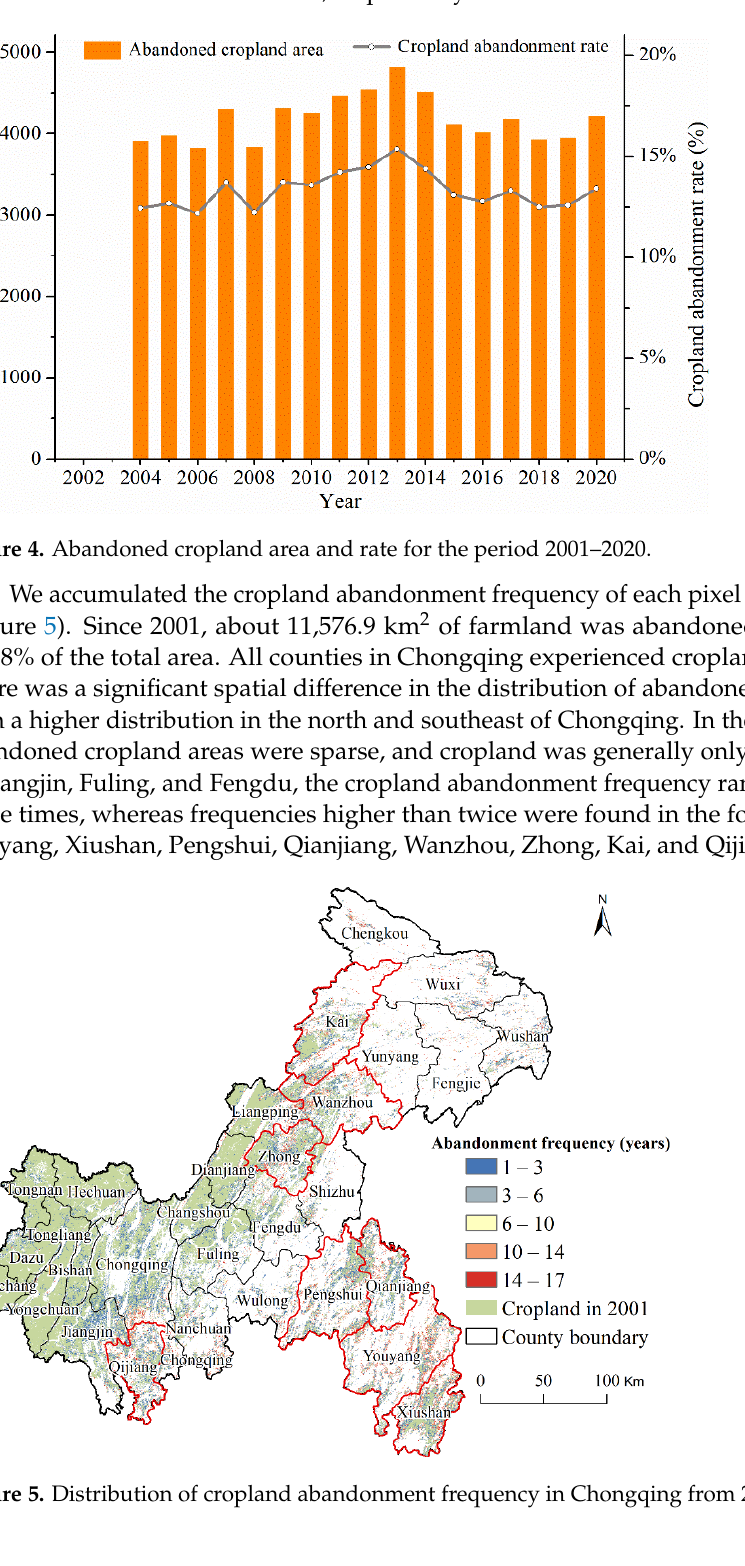
Figure 5. Distribution of cropland abandonment frequency in Chongqing from 2001 to 2020 . From 2001 to 2020, the cropland abandonment rate in most counties of Chongqing showed an increasing trend, whereas, in some areas, such as Chengkou and Wuxi, it